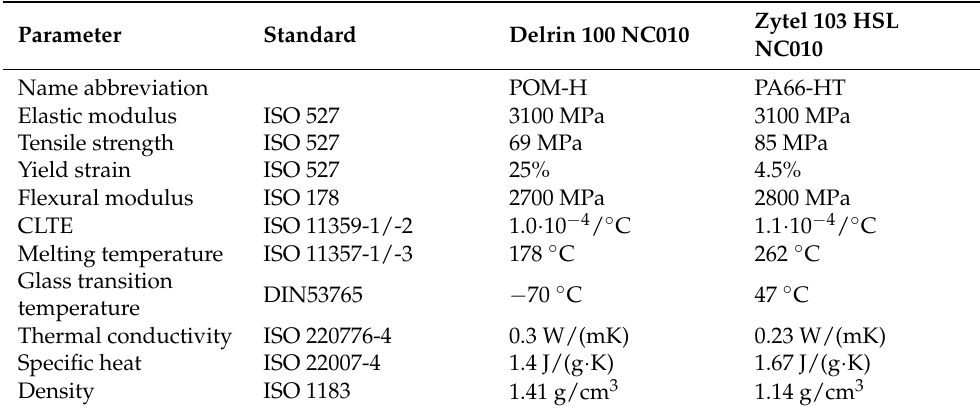
Table 3. Materials properties of tested